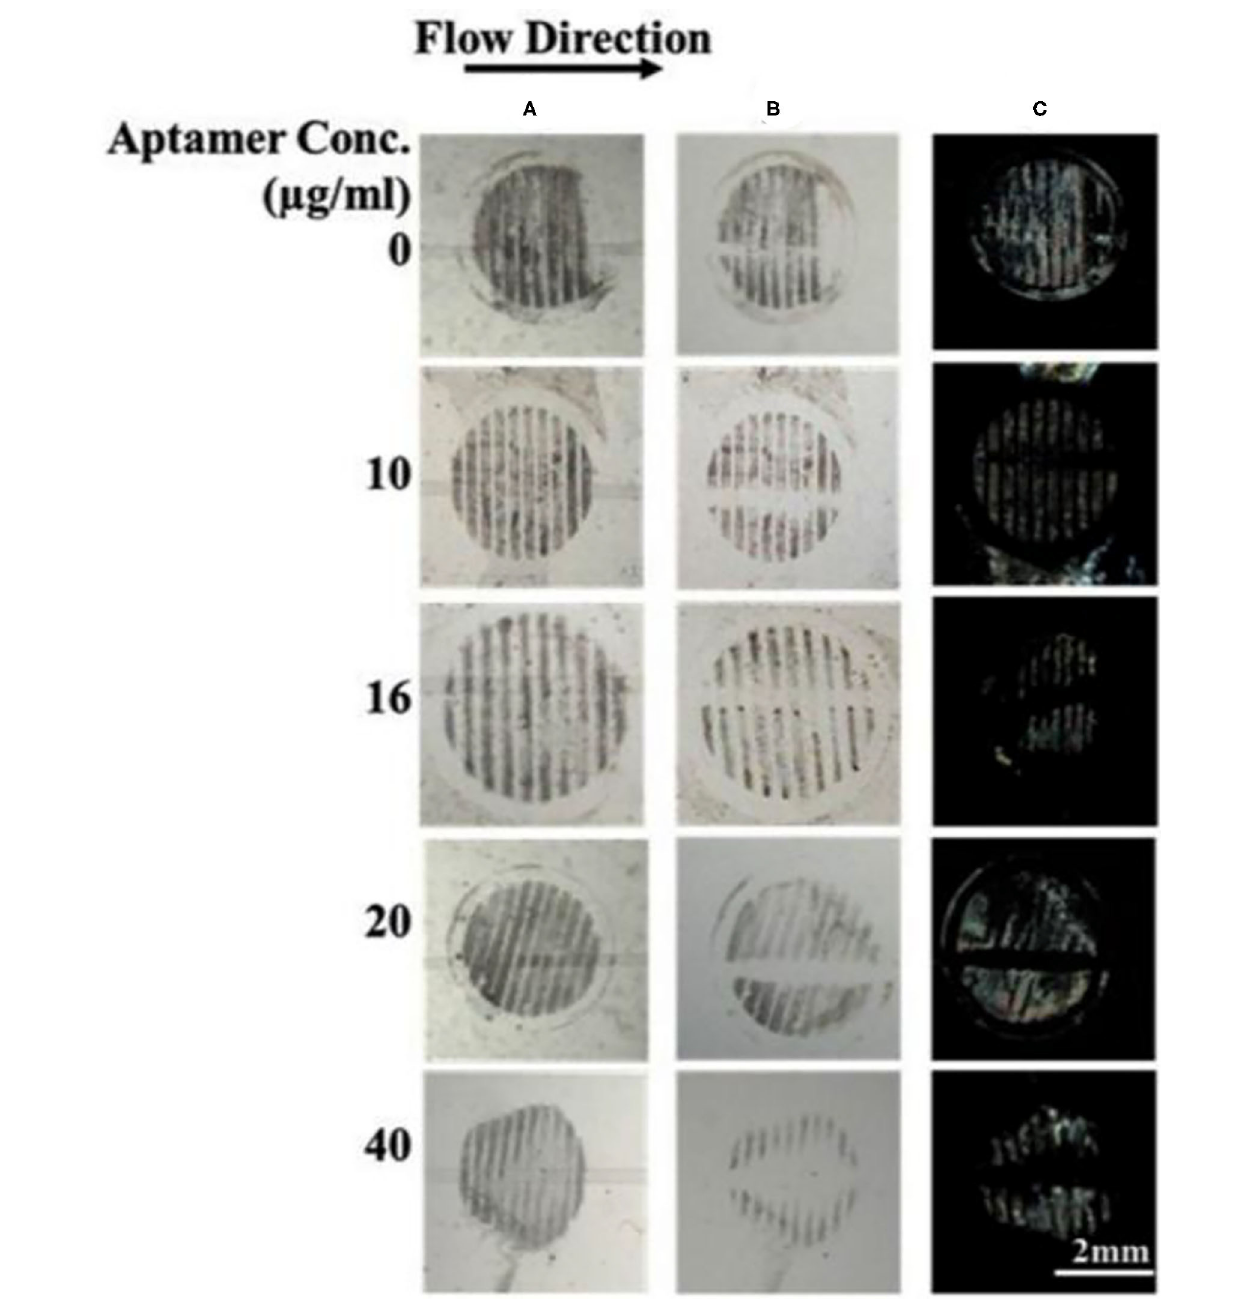
FIGURE 5 | Effect of aptamer concentration on the removal of surface-immobilized gp-120 from a DMOAP-coated surface. (A,B) Optical images of gp-120 patterns before and after flowing of different concentrations of B40t77 (0, 10, 16, 20, and 40 µ g/ml), respectively. (C) Optical images of LC after the assay was completed. The flow rate was 0.5 µ